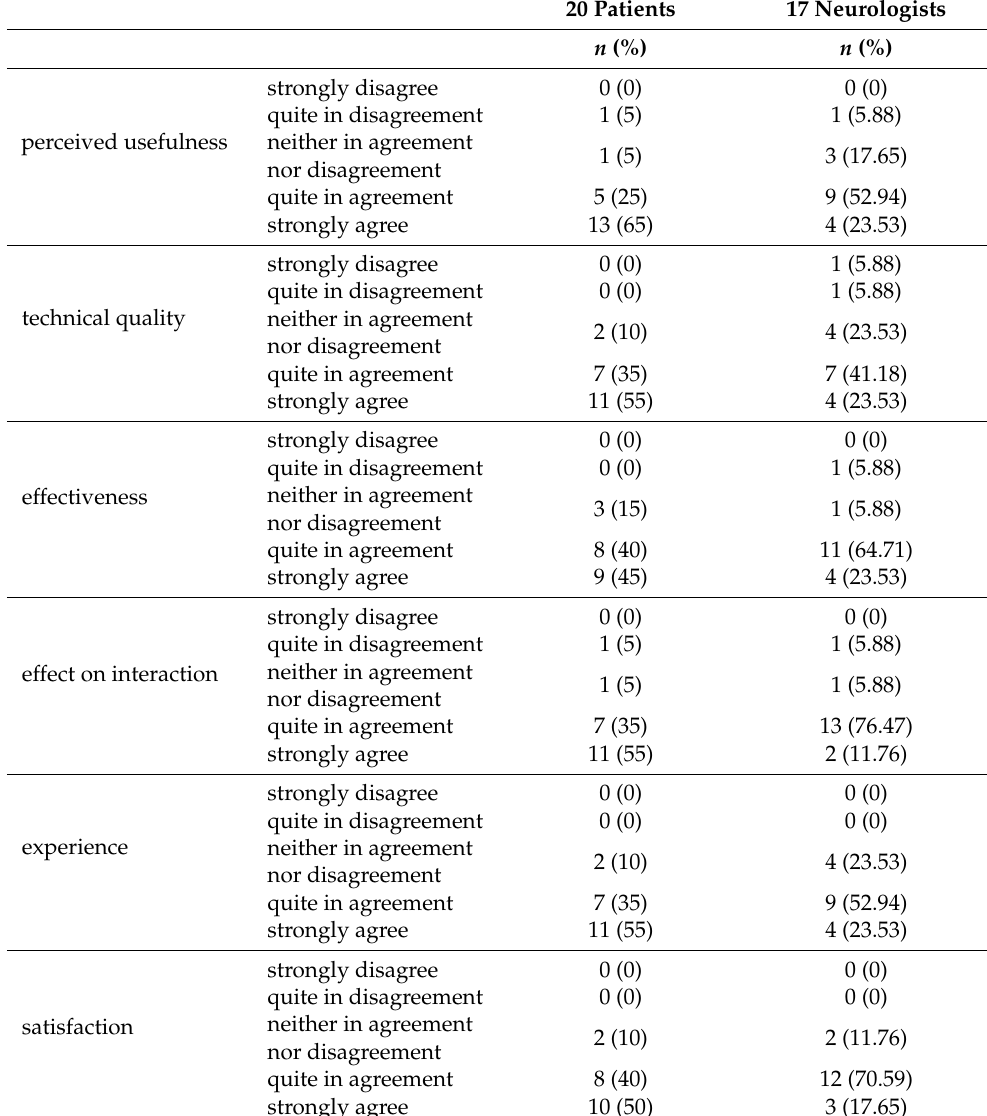
Table 3. Construct response data of PD patients and